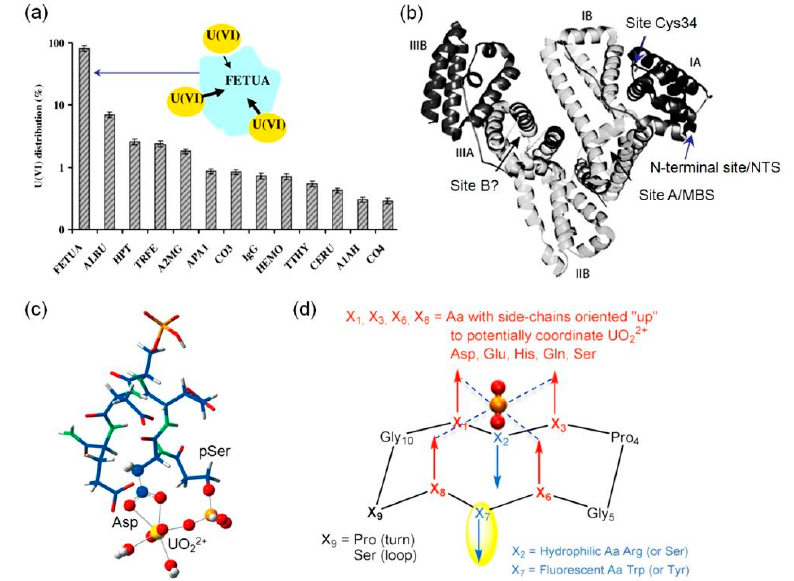
Figure 1. ( a ) Biodistribution of uranyl ions in serum proteins. A model of uranyl binding to fetuin-A